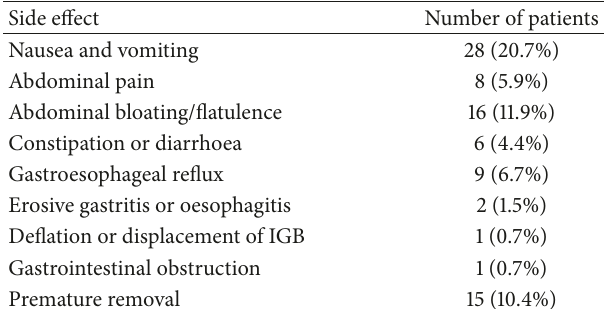
Table 4: Adverse